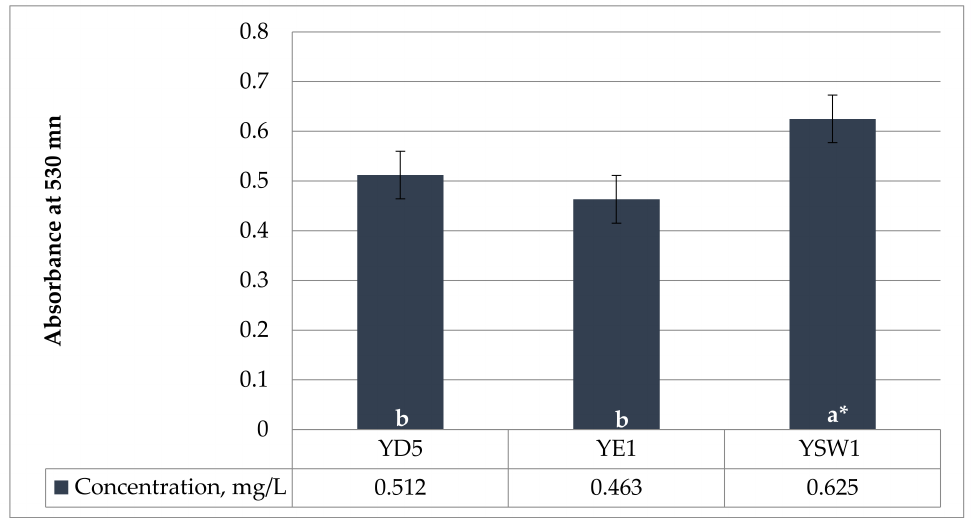
Figure 1. Production of indole-3-acetic acid (IAA) in YPD medium, with 0.1% ( w/v ) L-tryptophan, incubated in a shaker at 30 ◦ C and 150 rpm for 5 days. a and b indicate statistical references, * indicates high